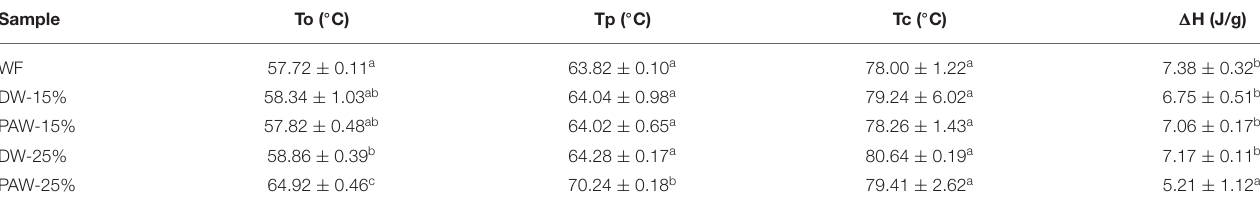
TABLE 1 | Thermal properties of wheat